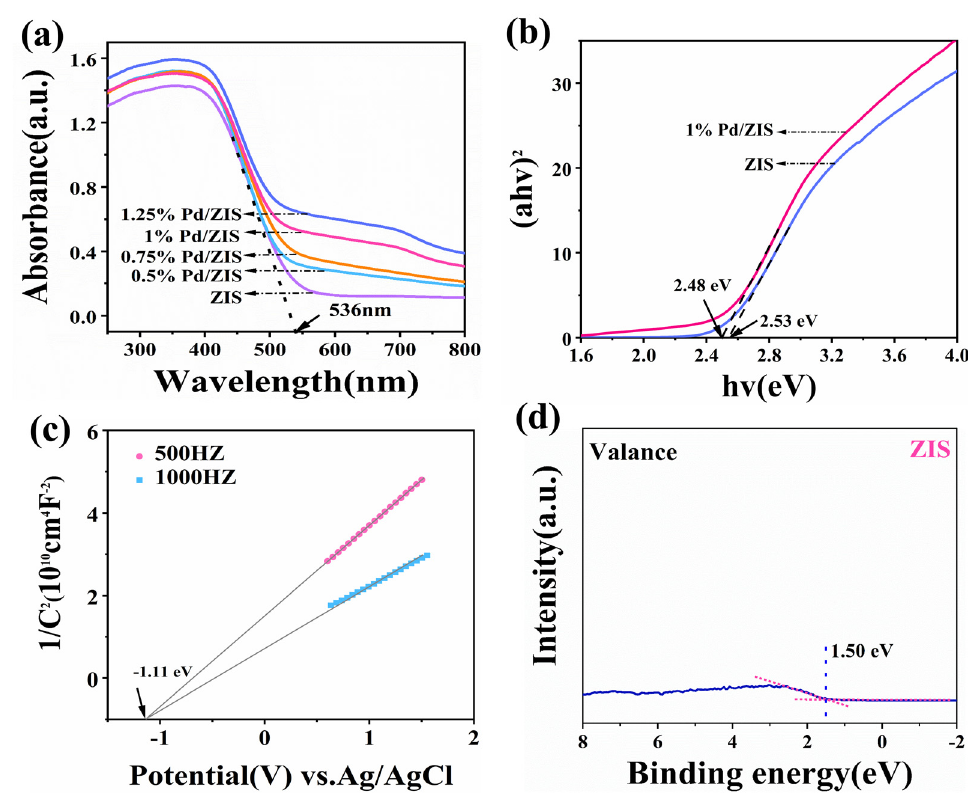
Figure 4. UV – vis diffuse reflectance ( a ) and optical band gap spectra ( b ) of ZIS and Pd/ZIS composites; ( c ) Mott–Schottky plots of ZIS; ( d ) valence band curves of ZIS.